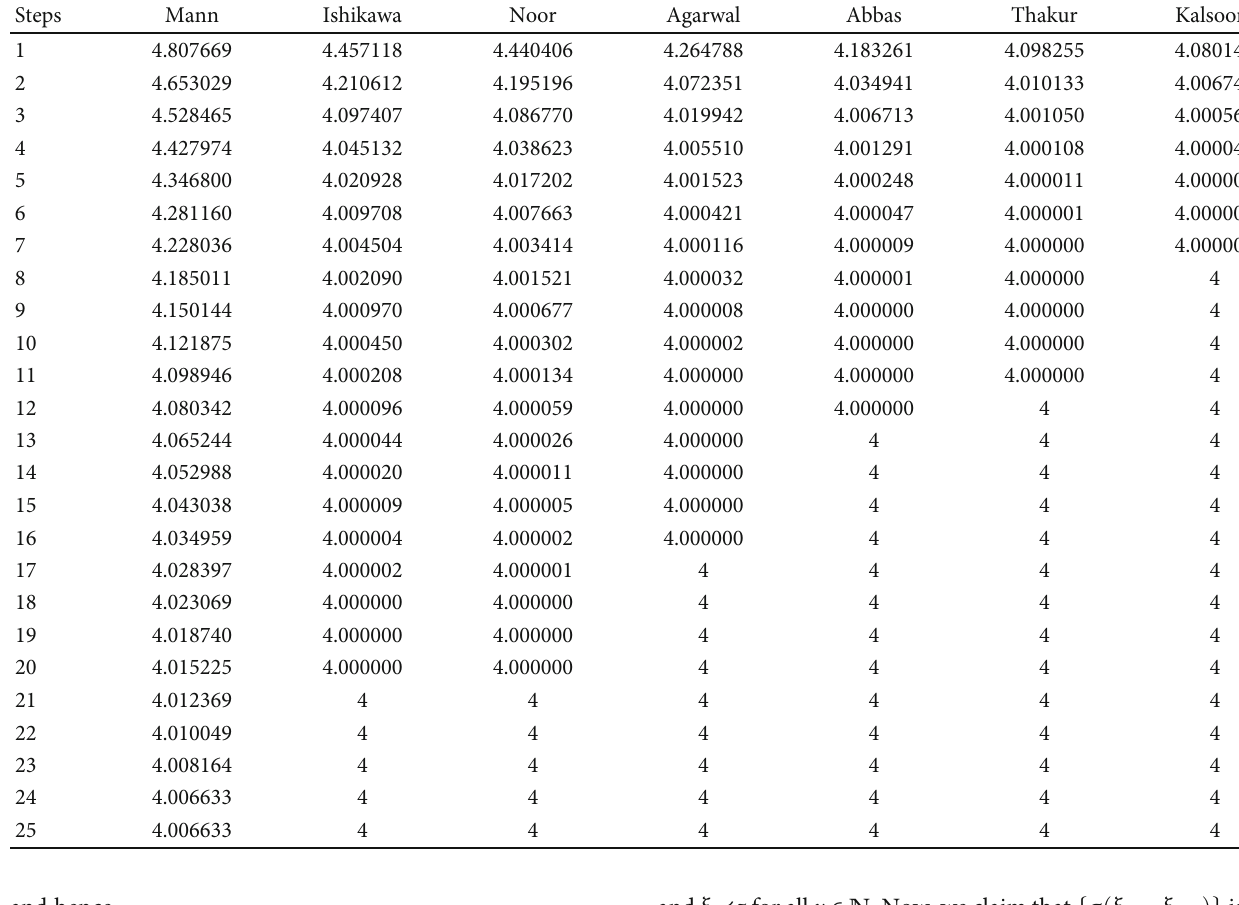
Table 2: Convergence behavior of Mann, Ishikawa, Noor, Agarwal, Abbas, Thakur and Kalsoom et al. iterations towards fi xed point. Steps Mann Ishikawa Noor Abbas